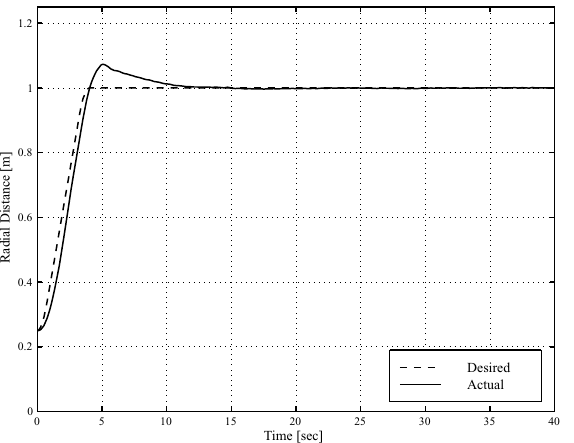
Fig. 19. Radial distance for the gantry case using the fuzzy controller.]Desired and actual radial distances for the gantry case using the fuzzy controller.